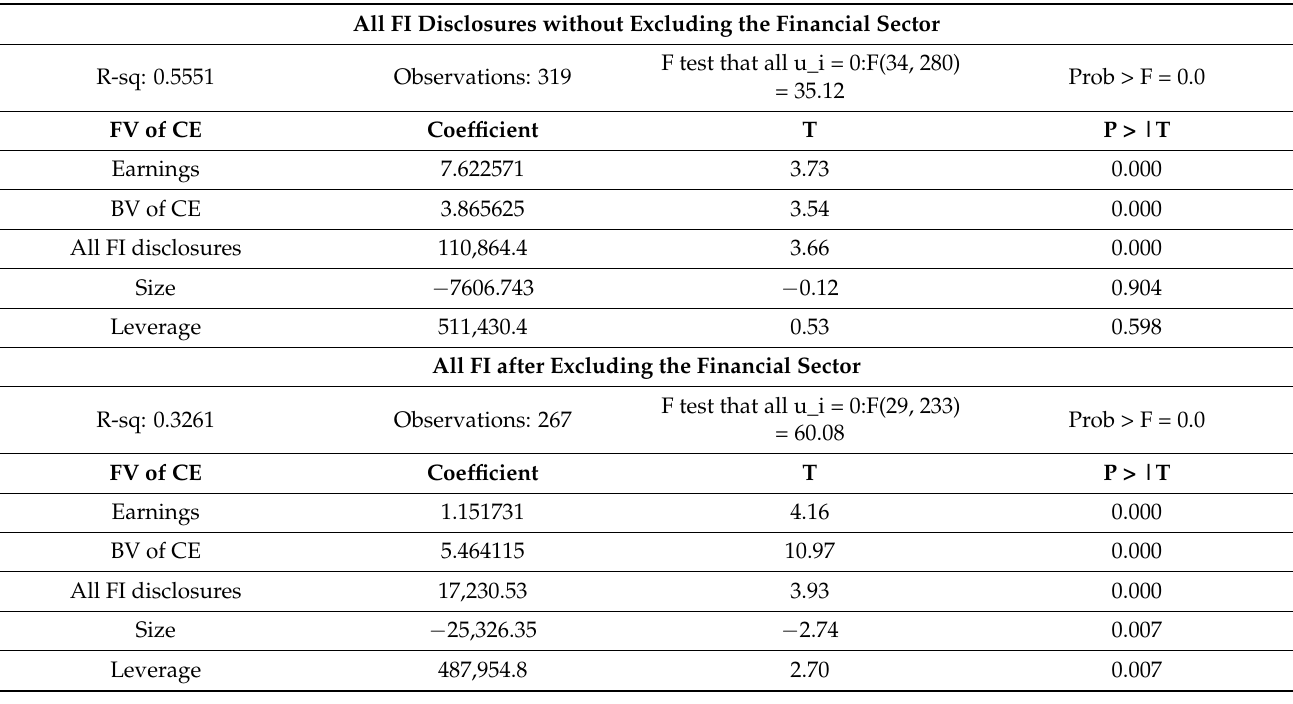
Table 3. The results of the fixed effects